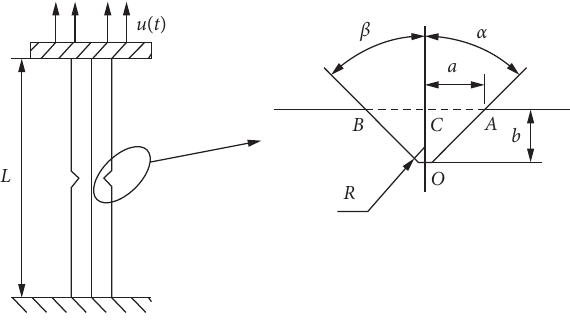
Figure 2: Tensile specimens.